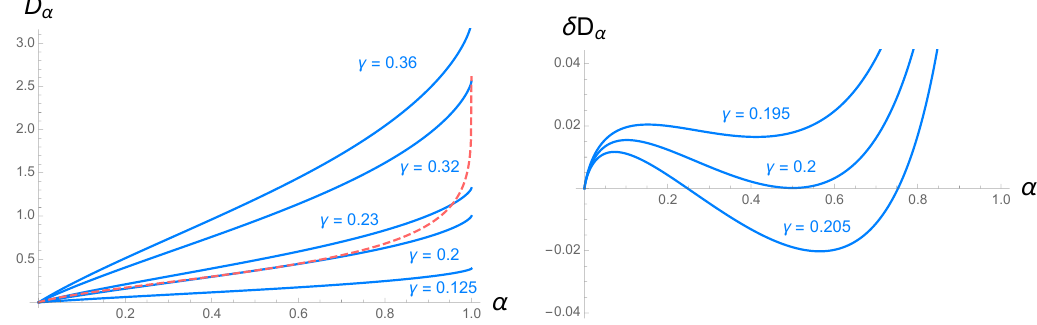
Figure 6 . (Left) D (cid:11) from perturbative holographic calculations for (cid:1) 1 = 0 : 9 (dashed curve) and (cid:1) 2 = 0 : 6 (solid curves). The di(cid:11)erent (cid:1) 2 = 0 : 6 curves correspond to di(cid:11)erent values of the ratio (cid:13) de(cid:12)ned in eq. (5.3). In particular, we show (cid:13) = 0 : 125 ; 0 : 2 ; 0 : 23 ; 0 : 32 ; 0 : 36 from the lowest to the highest. (Right) (cid:14)D (cid:11) (cid:17) D (cid:11) ( (cid:26) 1 k (cid:26) (cid:12) ) (cid:0) D (cid:11) ( (cid:26) 2 k (cid:26) (cid:12) ) for values of (cid:13) around (cid:13) = 0 : 2. Since the di(cid:11)erence is positive for (cid:13) . 0 : 2, the transition (cid:26) 1 ! (cid:26) 2 may be allowed in this regime. In both plots, we (cid:16) (cid:17) 2((cid:1) 1 (cid:0) 2) cL 2 (cid:25) rescaled the vertical axis by a factor (cid:21) 2 1 48 (cid:25) (cid:12)